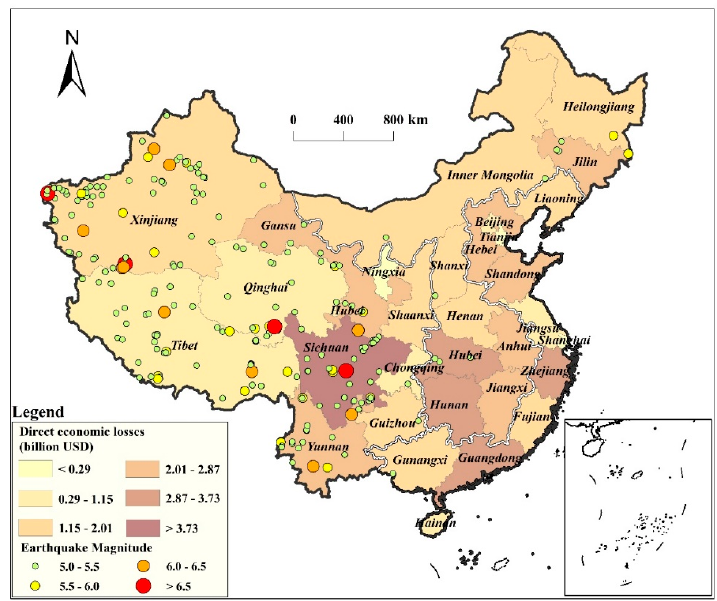
Figure 2. Spatial distribution of different magnitudes of earthquakes in China from 2010 to 2020. (The colored areas represent the annual averages of direct economic losses in administrative regions from 2010 to 2020).